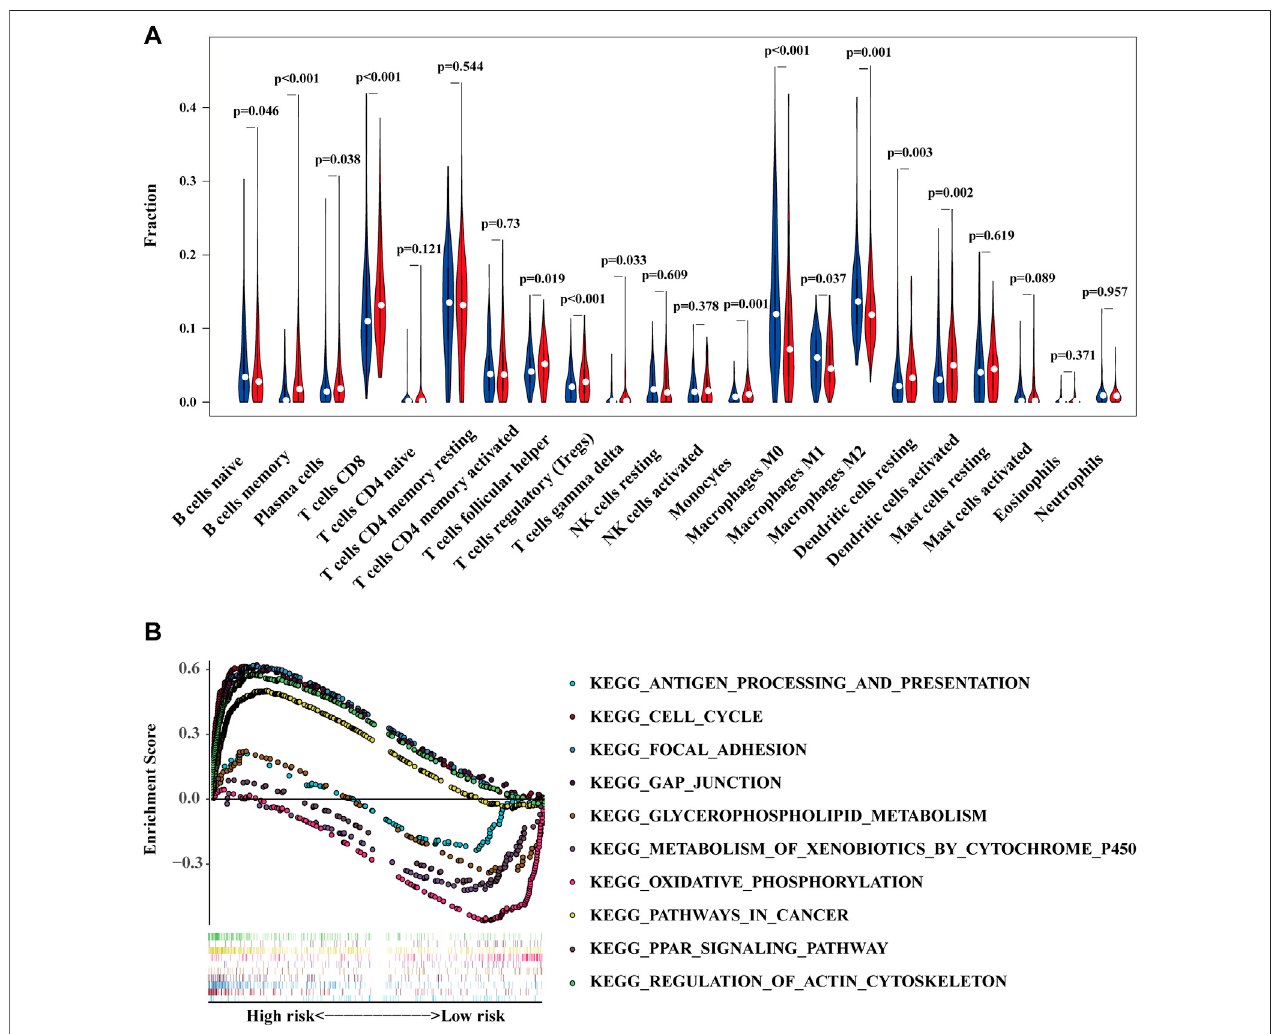
FIGURE 6 | The high- and low-risk groups demonstrate different immune cell in fi ltration status (A) and enriched pathways of KEGG (B) .